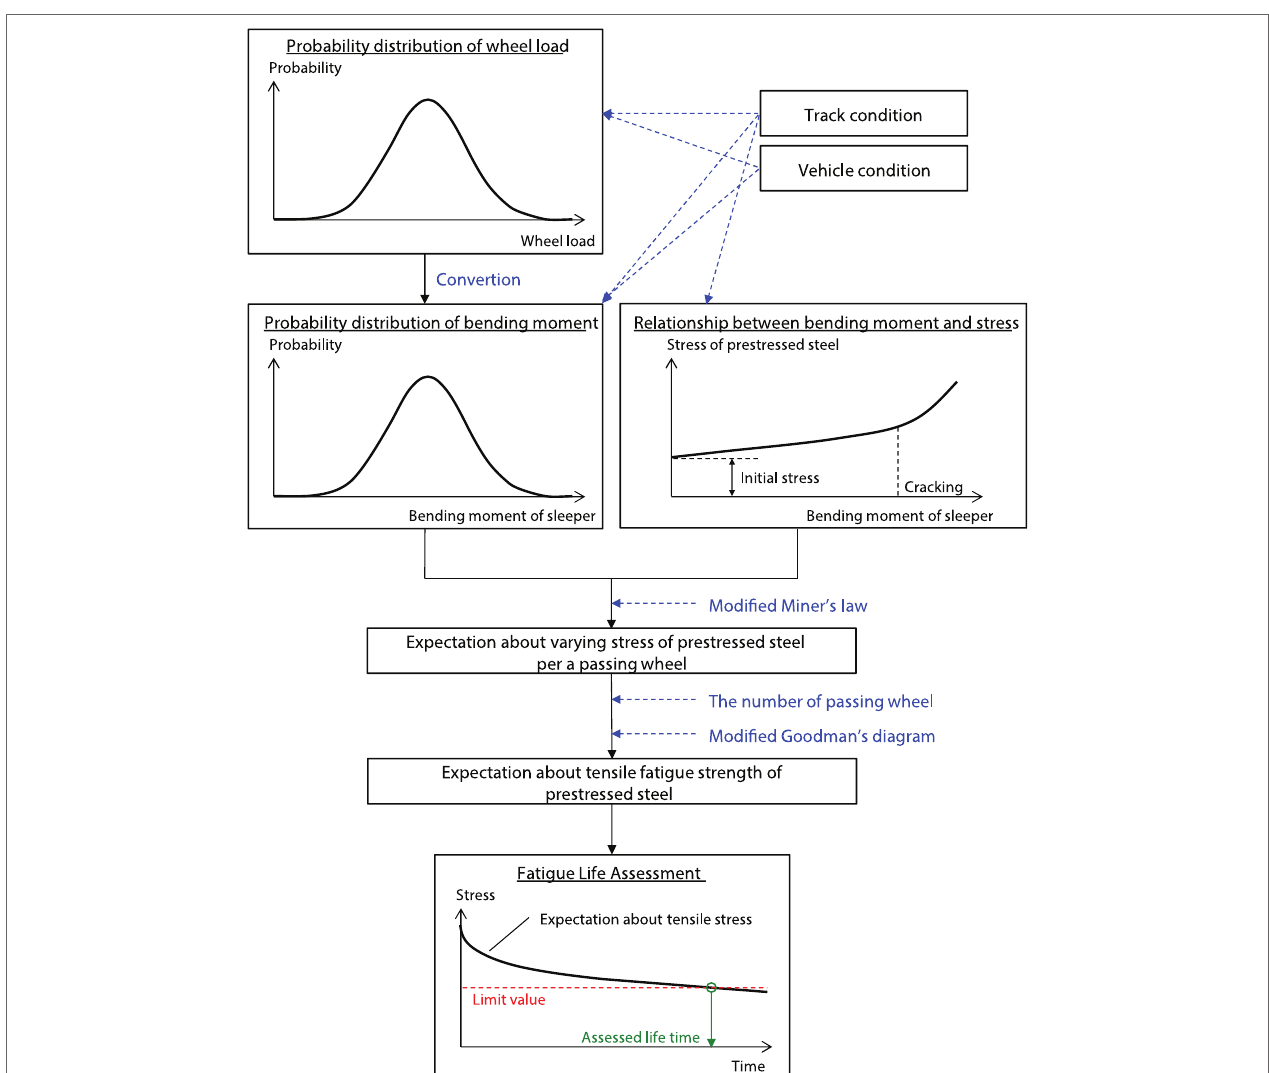
FiGUre 1 | Fatigue life assessment method for prestressed concrete